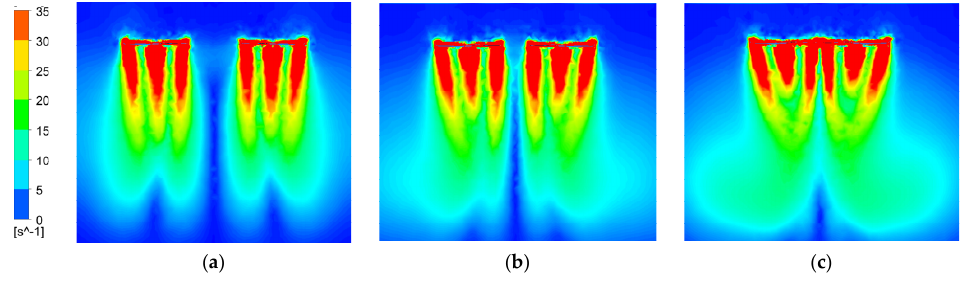
Figure 10. Vortices distribution. ( a ) L / D = 1.8; ( b ) L / D = 1.4; ( c ) L / D = 1.0.